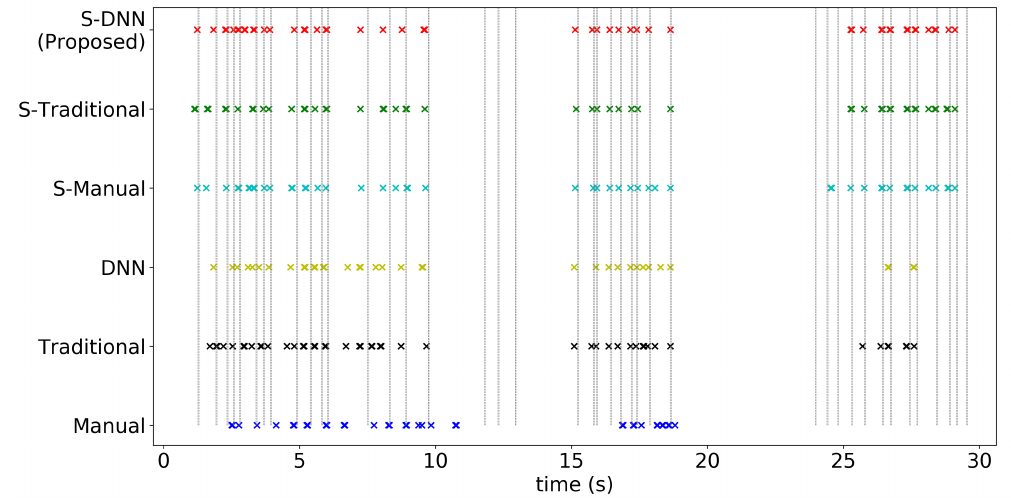
Figure A7. Prediction consistency of event counting compared with ground truths for capillary 1.